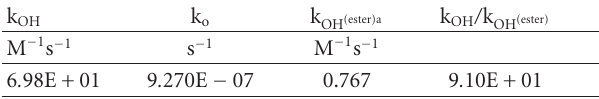
Table 4: Kinetic data for the hydrolysis of [Pd(DEEN)(cysteine methyl ester)] 2+ at 25 ◦ C and 0.1 M ionic